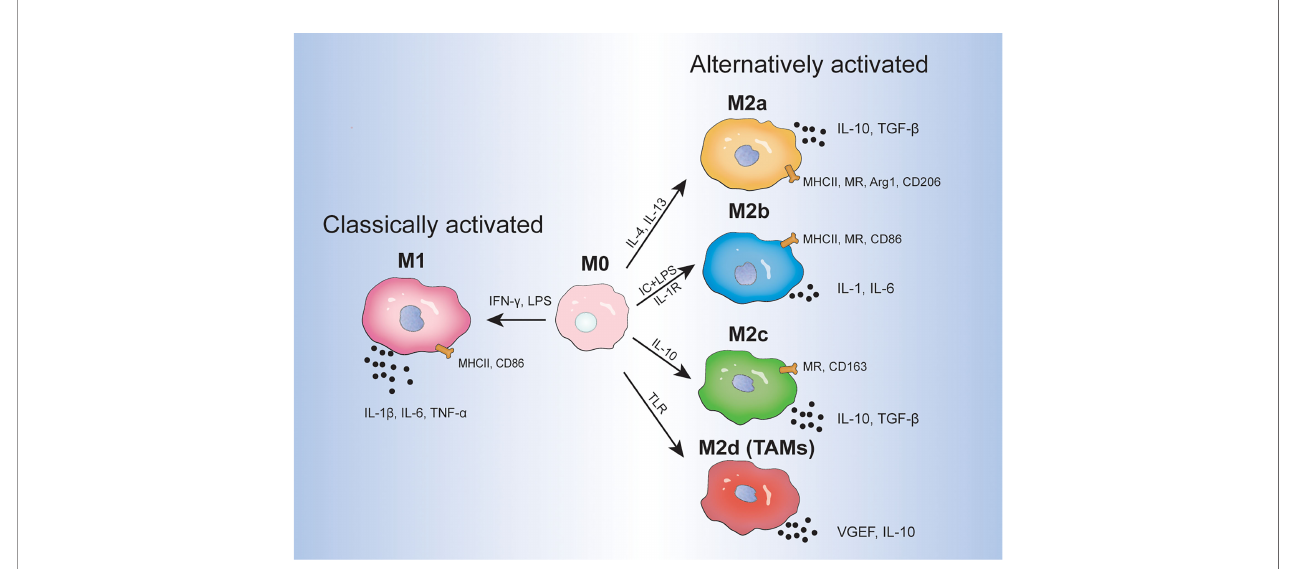
FIGURE 1 | The direction of macrophage differentiation in response to different environmental cues. IC, immune complex; LPS, lipopolysaccharide; TLR, Toll-like receptor; VEGF, vascular endothelial growth factor; MR, mannose receptor; Arg 1, arginase